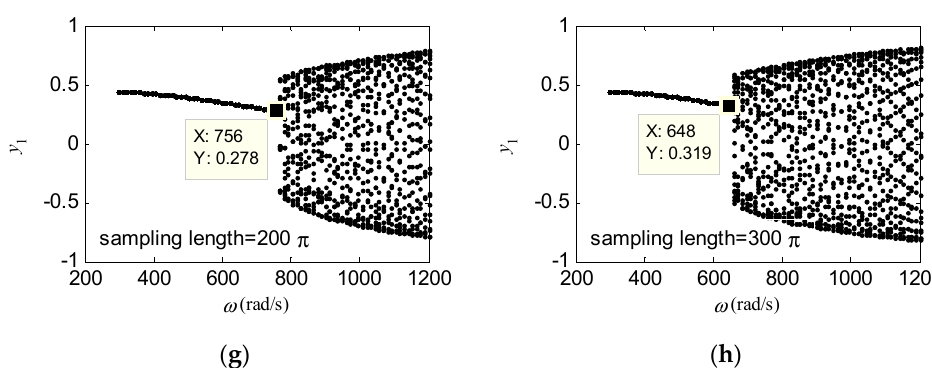
Figure 4. Bifurcation diagram ( a ) of original system, bifurcation diagrams, ( b – h ) of the proper orthogonal modes (POMs) of 2-degrees-of-freedom (DOF) for the different sampling lengths at the rotational speed 350 rad/s.